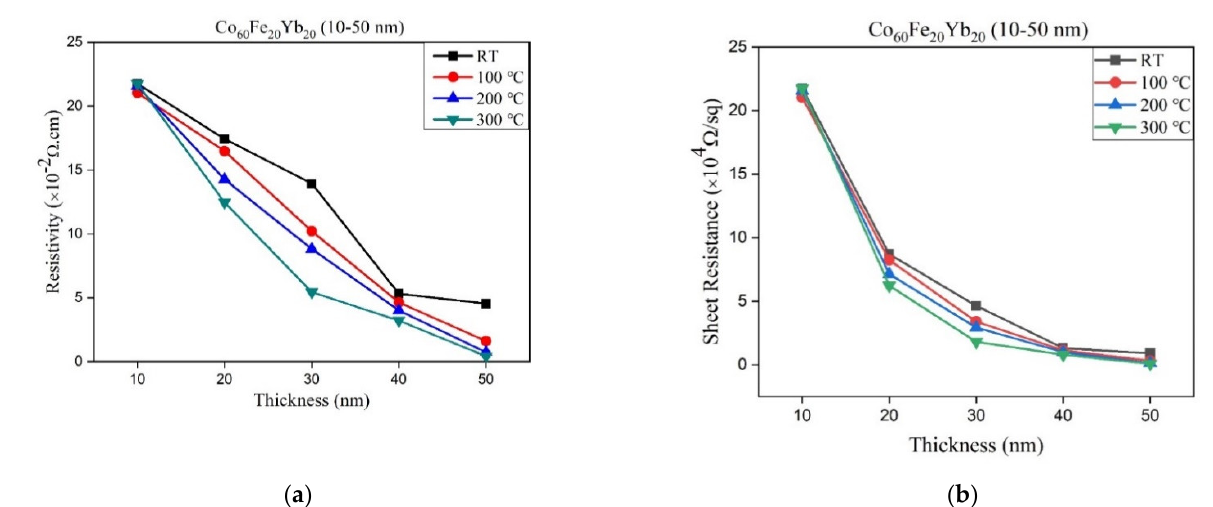
Figure 4. ( a ) The resistivity of CoFeYb films and ( b ) the sheet resistance of CoFeYb films.